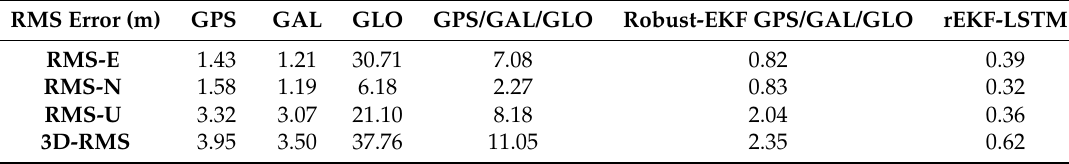
Table 4. RMS Errors in Position for the six scenarios at station ABMF in late 12 h.